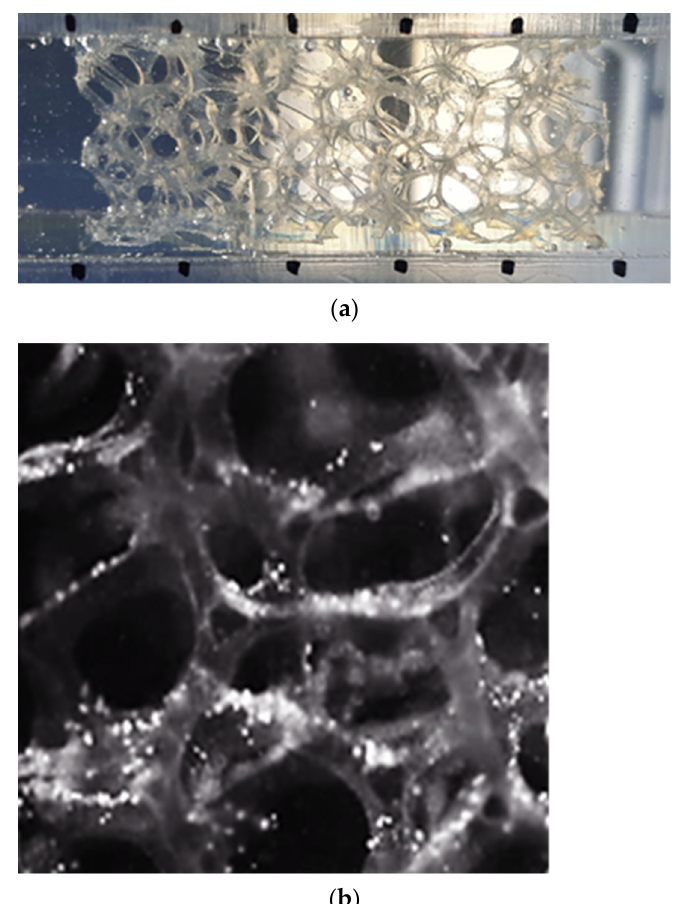
Figure 4. Test section with refractive-index-matched solution and transparency of the 3D printed model: ( a ) without laser illumination; ( b ) with laser illumination.